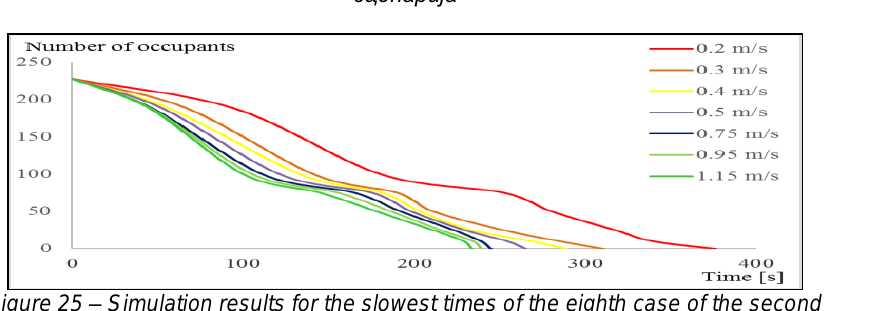
Figure 25 – Simulation results for the slowest times of the eighth case of the second